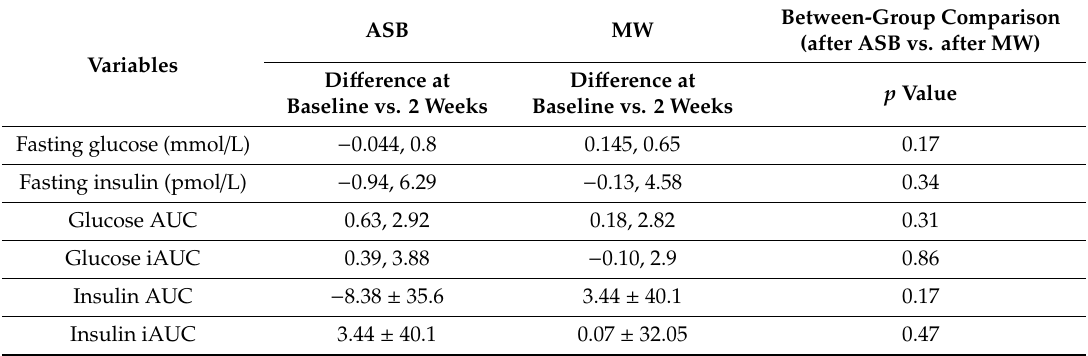
Table 3. E ff ects of artificial sweeteners aspartame and acesulfame K in between-group comparison. Between-Group Comparison ASB MW (after ASB vs. after MW) Variables Di ff erence at Di ff erence at p Value Baseline vs. 2 Weeks Baseline vs. 2 Weeks Fasting glucose (mmol / L) − 0.044, 0.8 0.145, 0.65 0.17 Fasting insulin (pmol / L) − 0.94,